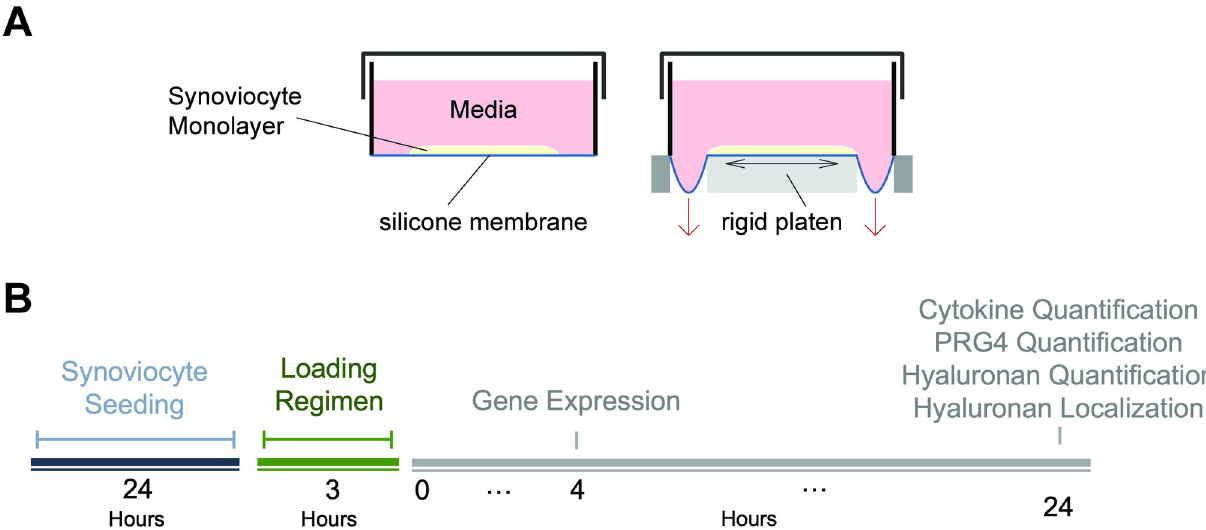
Fig 1. Experimental set-up of Flexcell loading system. A) Vacuum-controlled pressure is used to stretch the silicone membrane evenly across the loading post. B) Synoviocytes were seeded for 24 hours and loaded for 3 hours before measuring outcomes at specific